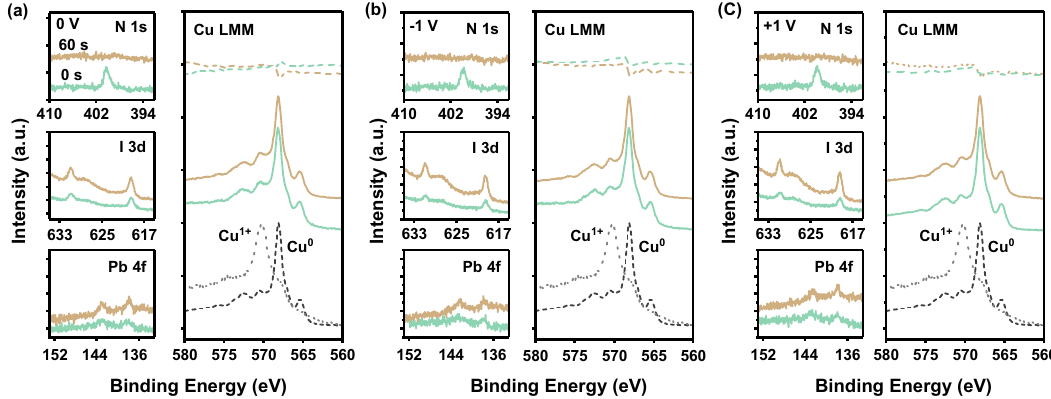
Fig. 4 Depth-dependent XPS pro fi les for the cleaved Cu electrode side. a – c The distributions of N, I, Pb, and Cu for PSCs with and without electric stress. a 0 V, b − 1 V, and c + 1 V. The difference spectra (raw data minus Cu 0 reference spectrum 55 , noted as the dashed line in the Cu LMM graph) show the Cu electrode are mainly Cu 0 feature, indicating the Cu electrode is not affected by the diffused I 2 signi fi cantly. The differentiation between metal and oxides of copper ’ s chemical states is indistinguishable in Cu 2p XPS spectra. Thus, the Cu LMM Auger spectra are used to help assign chemistry 56 . The Cu 2p 3/2 spectra of these corresponding samples are provided in Supplementary